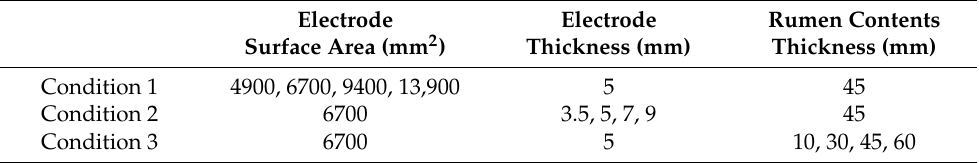
Table 1. Experiment parameters in the case of changing the electrode’s surface area (Condition 1), electrode thickness (Condition 2) of bamboo charcoal electrodes, or rumen content’s thickness (Condition 3).